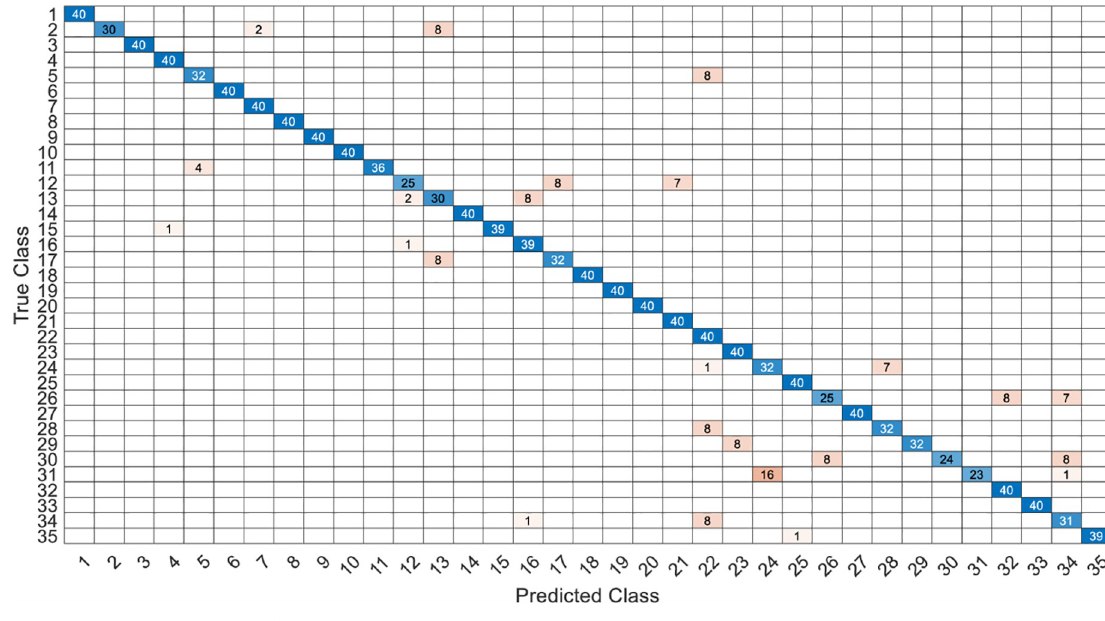
Fig 31. The confusion matrix of DNN-12-layer model with LPC